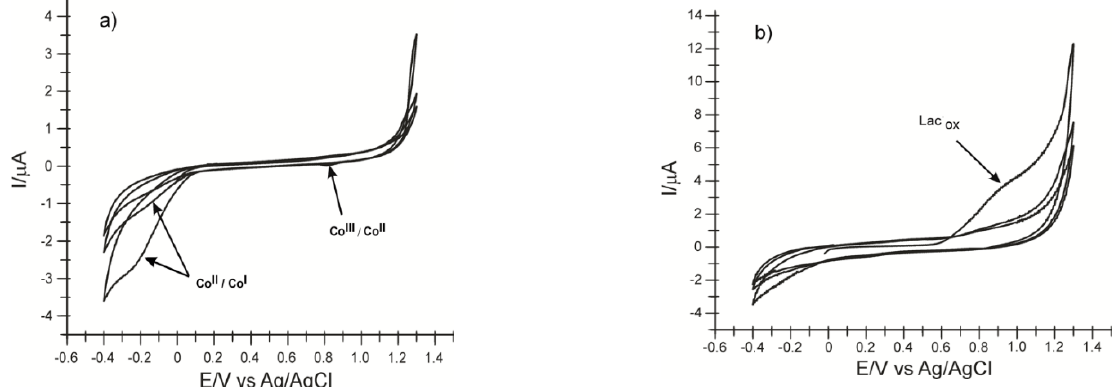
Figure 3. Cyclic voltammograms of CNF-CoPc/SPE ( a ) and CNF-CoPc-Lac/SPE ( b ) immersed in PBS solution 0.1 M pH = 5.0. Three successive cycles.